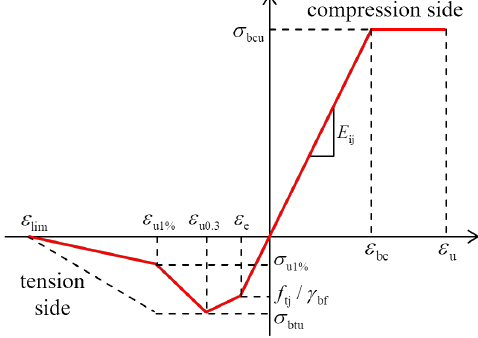
Figure 1. Stress–strain diagram for UHPC.